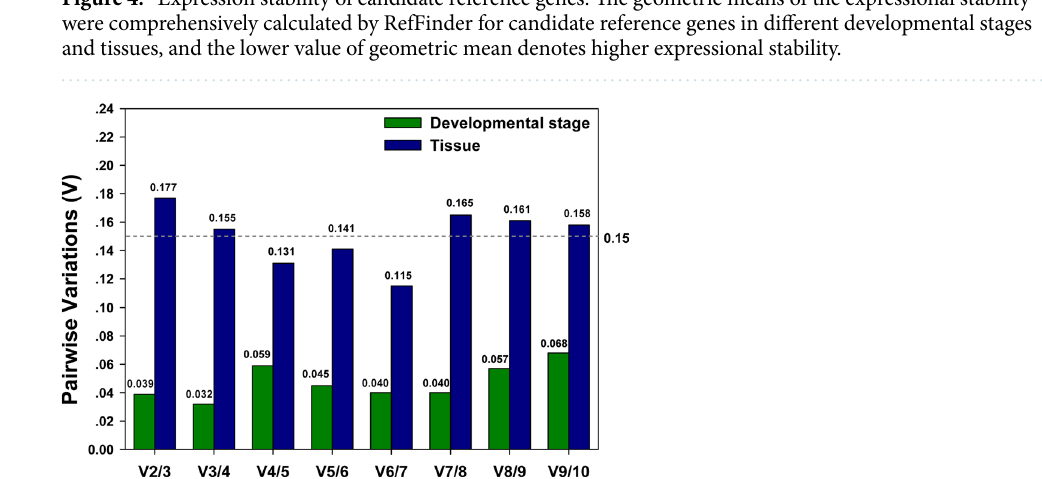
Figure 5. Pairwise variation analysis by geNorm. Optimal number of reference genes required for accurate normalization of target transcript expressions among different developmental stages and different tissues were determined by geNorm analysis based on pairwise variations of V n/n + 1